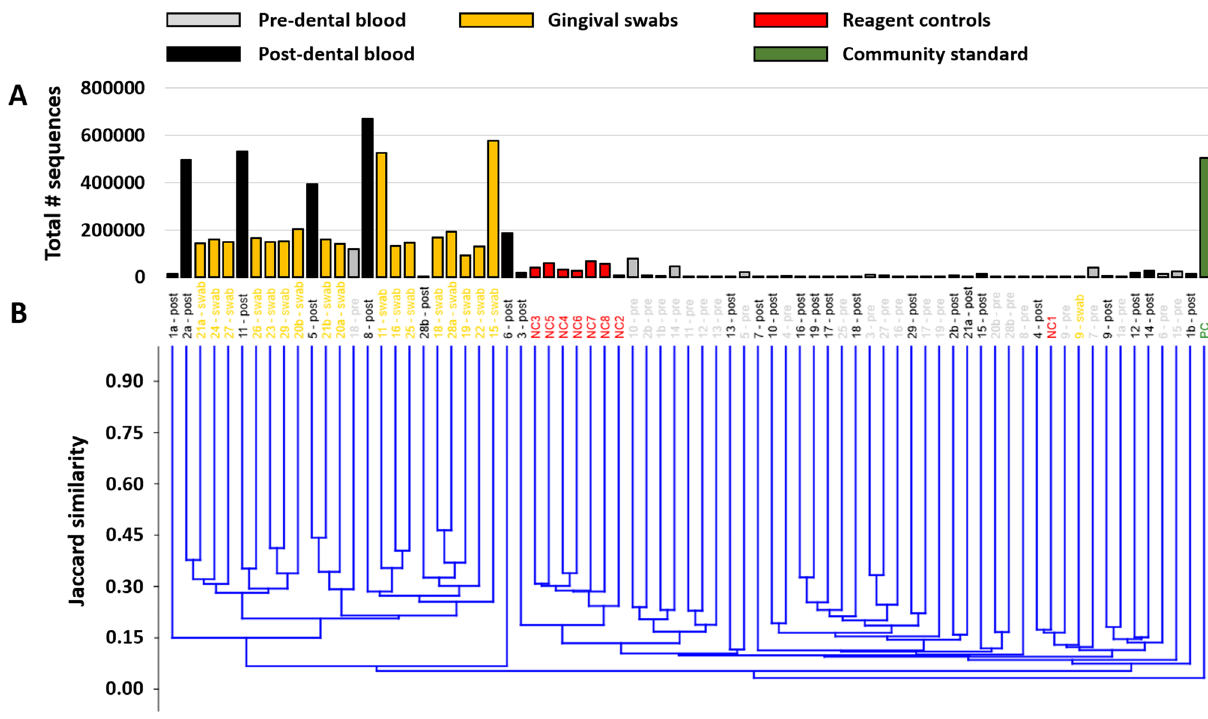
Figure 2. Bar chart showing sample coverage in those samples yielding > 1054 sequences, legend at top ( A ), and a dendrogram generated from those data, rarefied to a uniform coverage of 1054 sequences/sample ( B